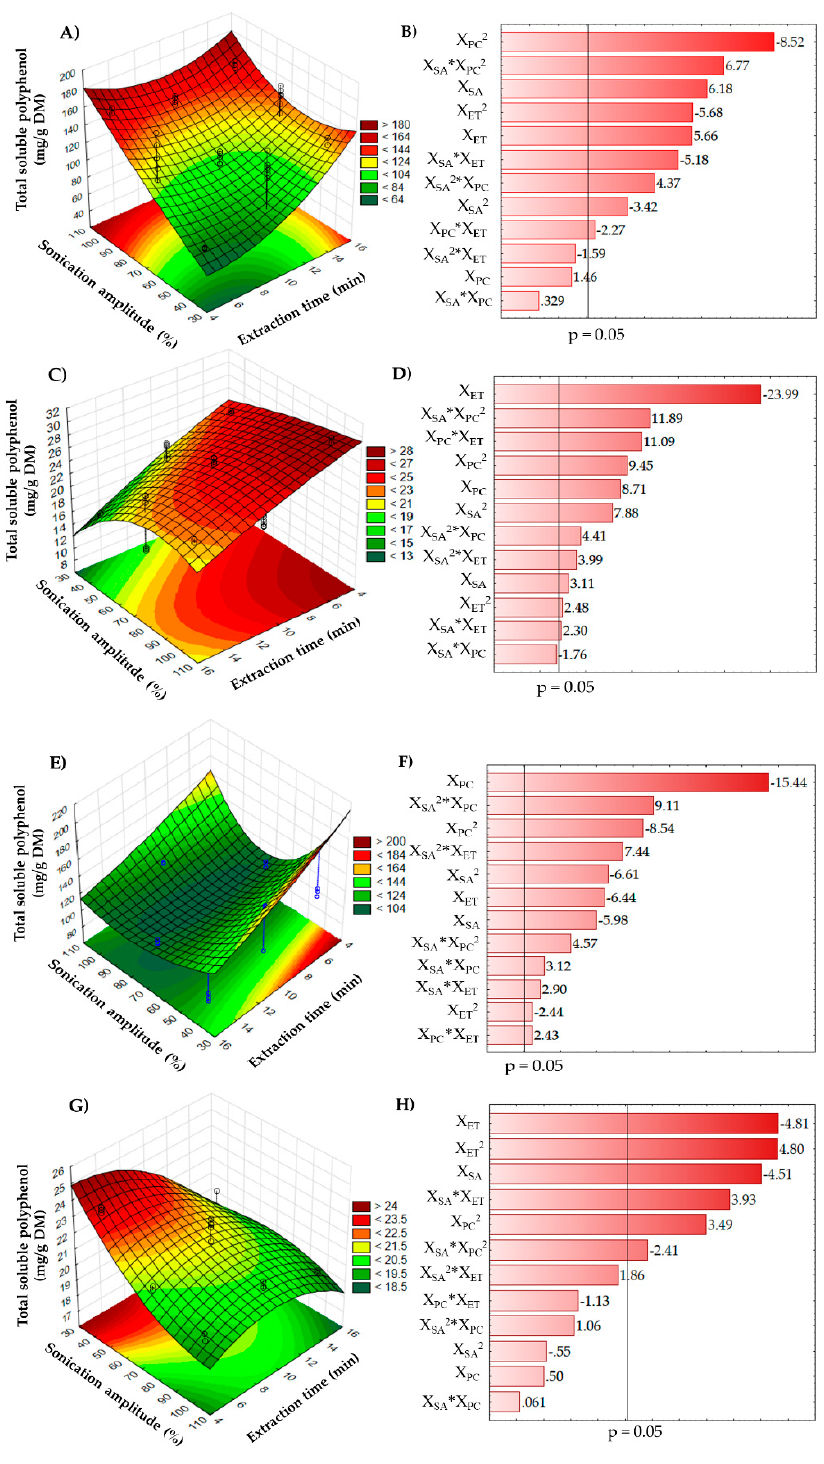
Figure 1 . Response surface plots and Pareto charts for soursop peel ( A , B ), seeds ( C , D ), columella ( E , F ), and pulp ( G , H ) showing the effect of ultrasound-assisted extraction on the soluble polyphenol content. DM, dry matter; X ET , exposition time (min); X SA , sonication amplitude (%); X PC , pulse cycle.